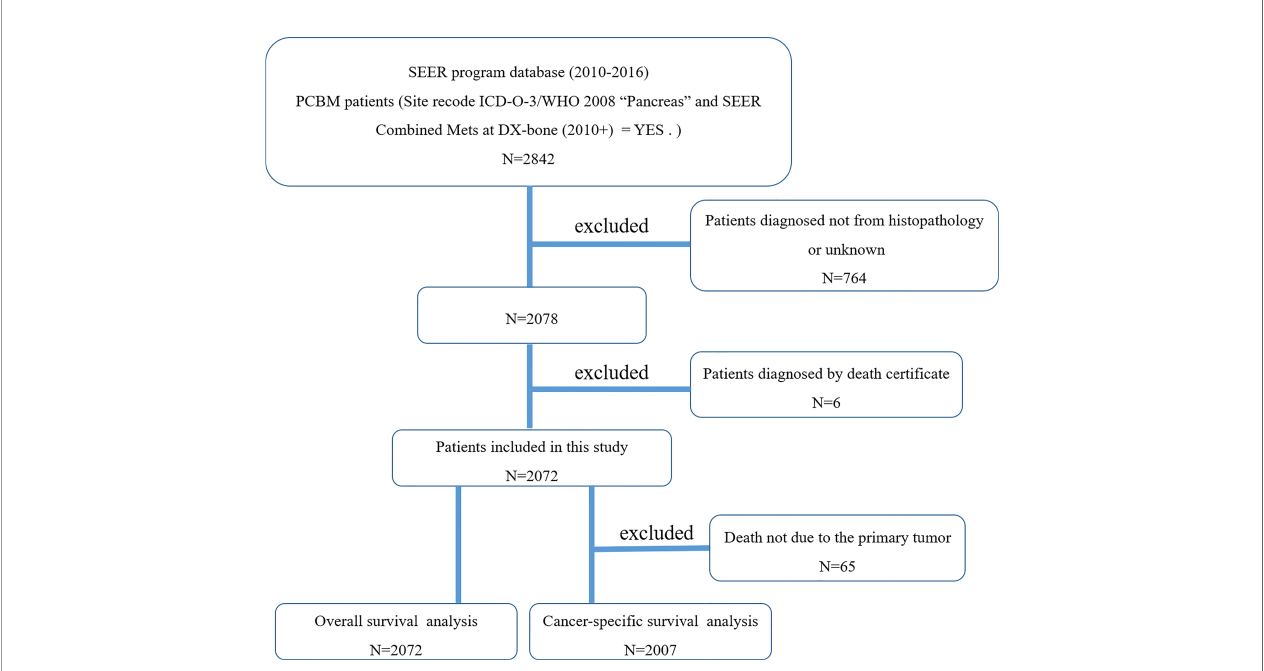
FIGURE 1 | The fl ow chart for selection of study population. (SEER, Surveillance, Epidemiology, and End Results; ICD-O-3, international classi fi cation of diseases for oncology, 3 rd edition; PCBM, pancreatic cancer bone